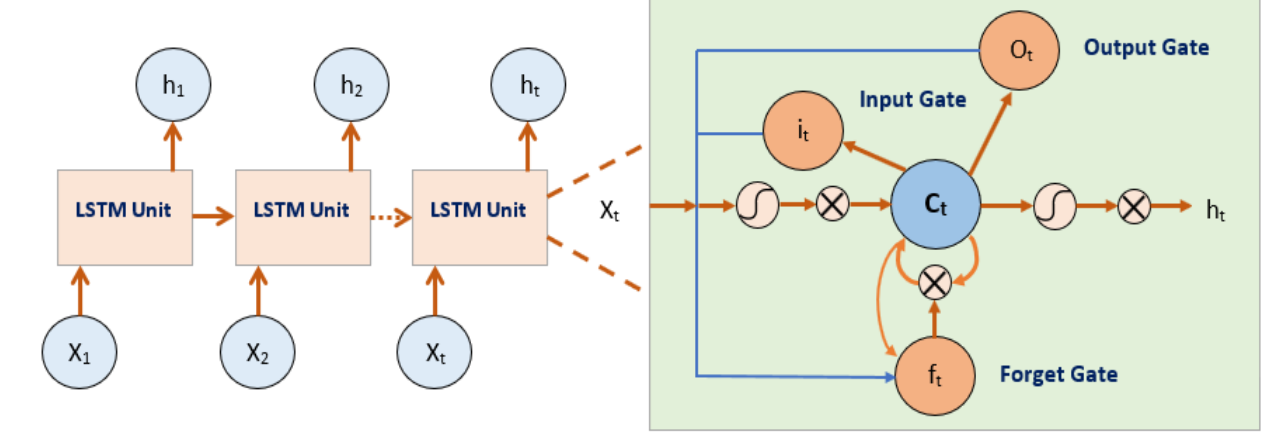
Figure 3. The fundamental design of LSTM.